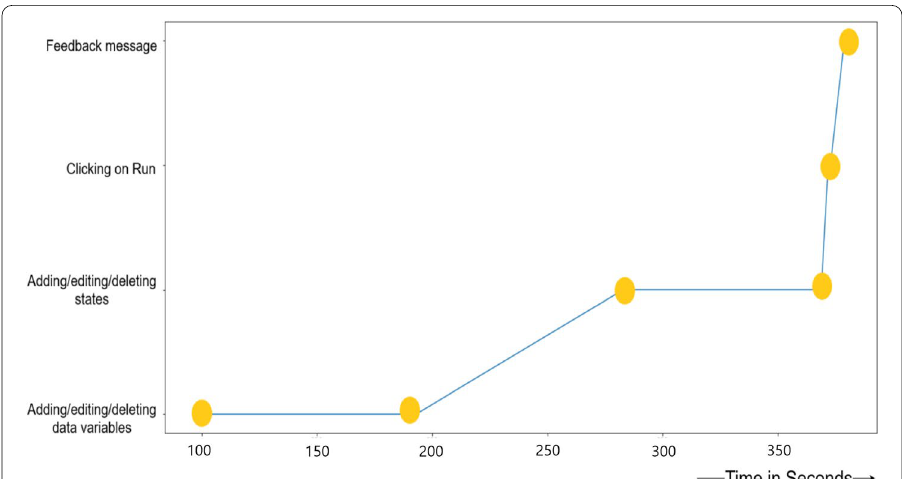
Fig. 15 Example graph of the single run